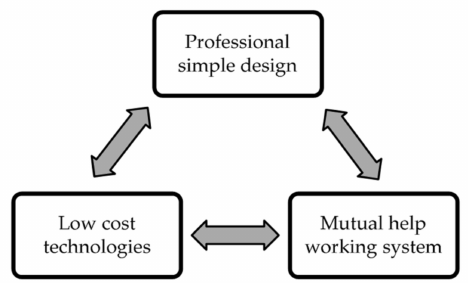
Figure 1. Simple Housing Solution (SHS) methodology